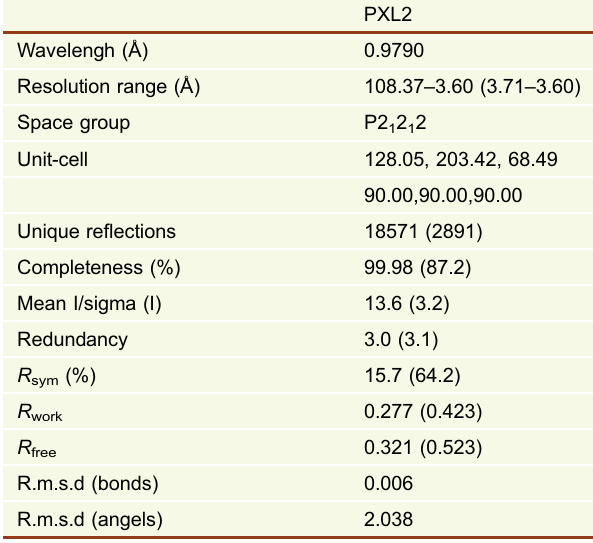
Table 1. Datacollection and re fi nement